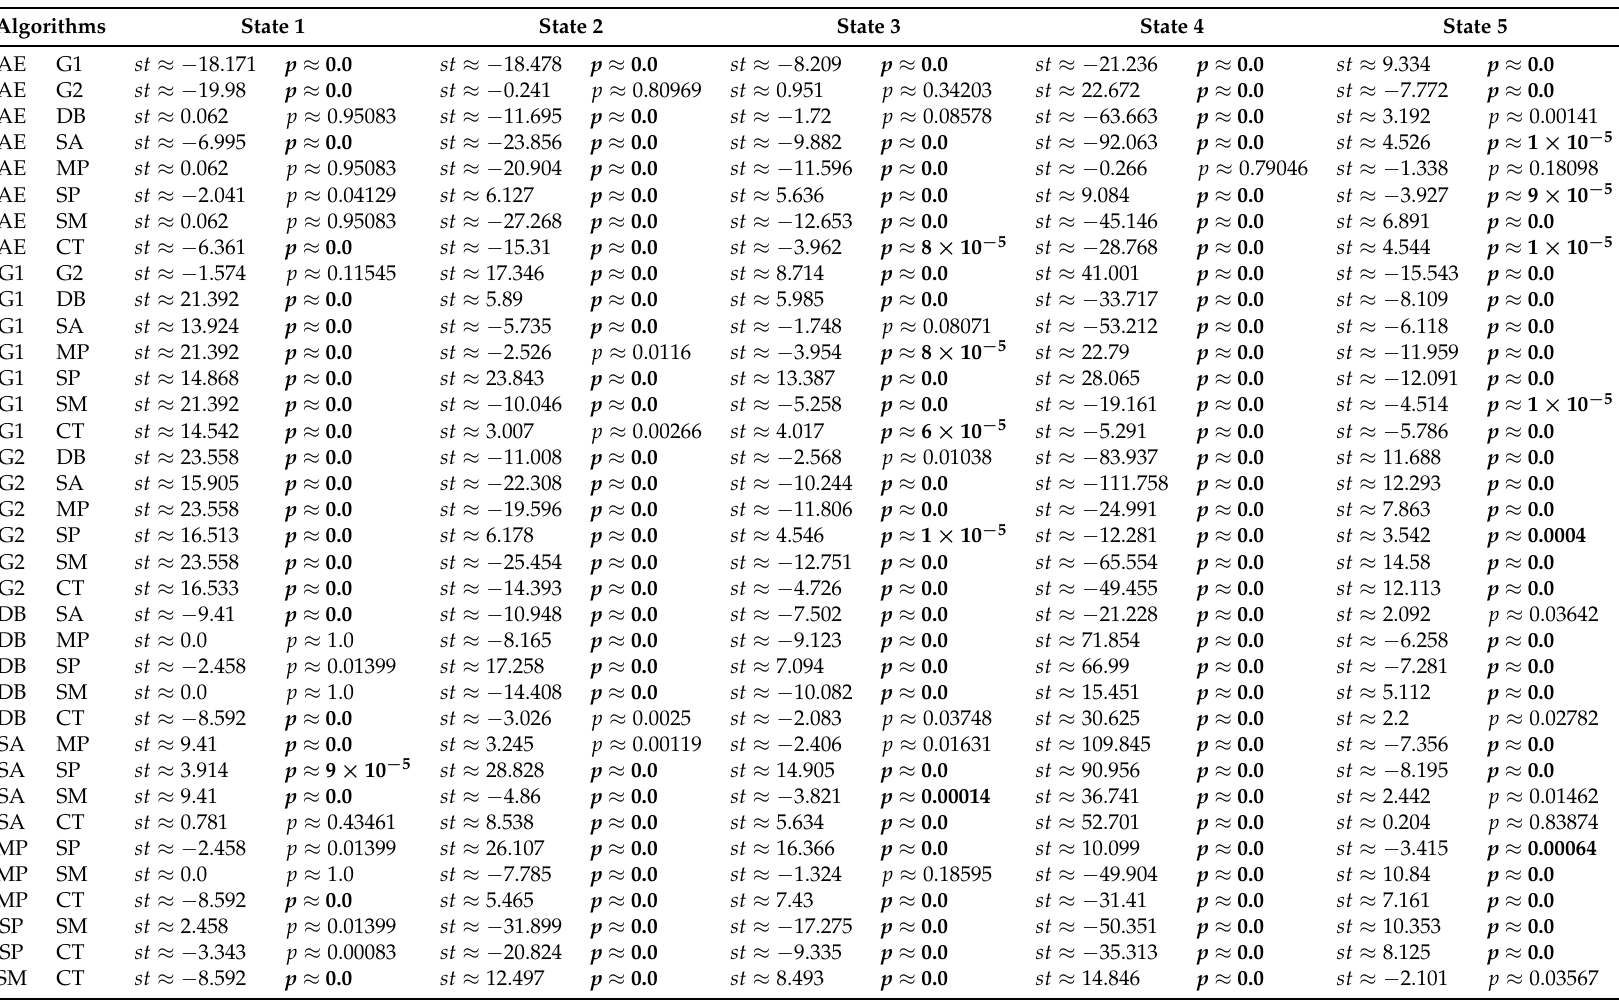
Table 7. Independent t -test applied to the data obtained from Environment 1. The Bonferroni correction was used to adjust the significance value, so that, at a confidence level of 95%, two strategies are significantly different if their p value is lower than 0.00069. The p values of such comparisons are typeset in